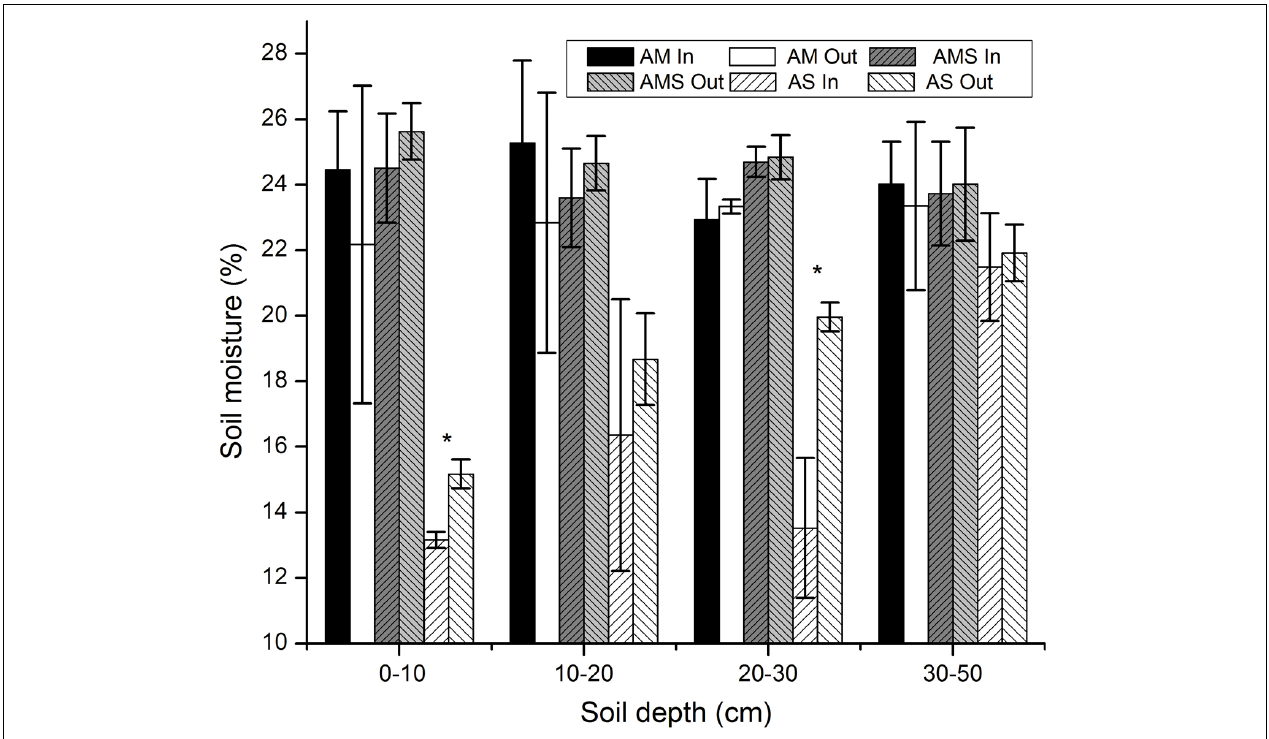
FIGURE 3 | Soil moisture in the vertical direction between enclosed (In) and grazed (Out) sites with three vegetation types: alpine meadow (AM), alpine meadow steppe (AMS), and alpine steppe (AS). Error bars were the standard error of three replicates soil moisture between enclosed and grazed sites; *Mean of the change of soil moisture was significant at P <